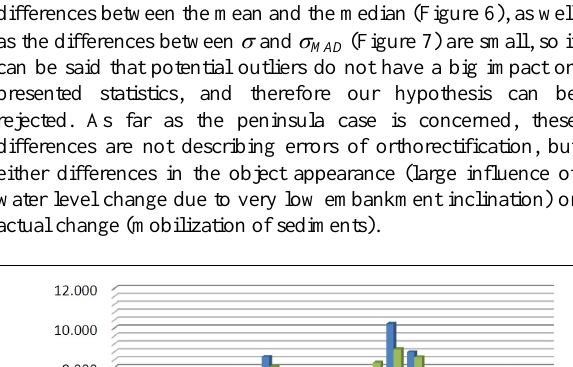
Figure 9. σ and σ MAD histogram for the test site